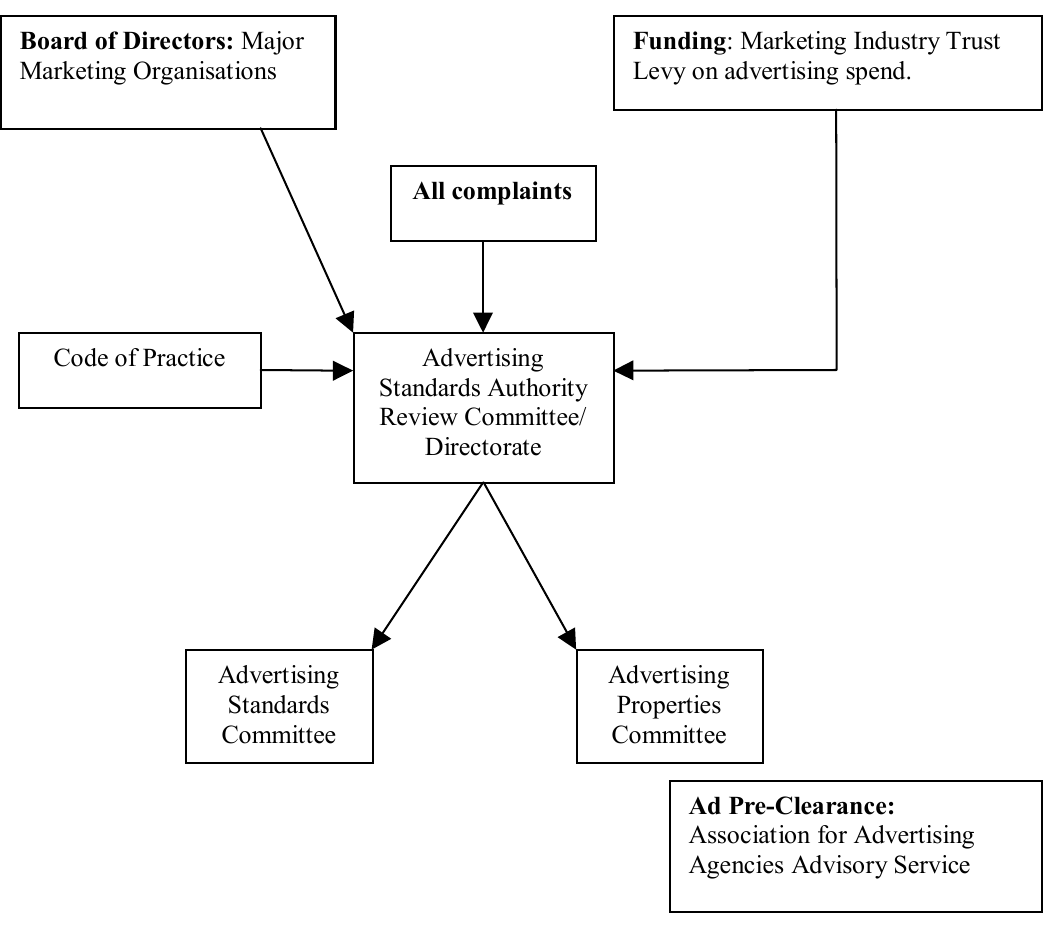
Figure 3: The structure of advertising self-regulation in South Africa